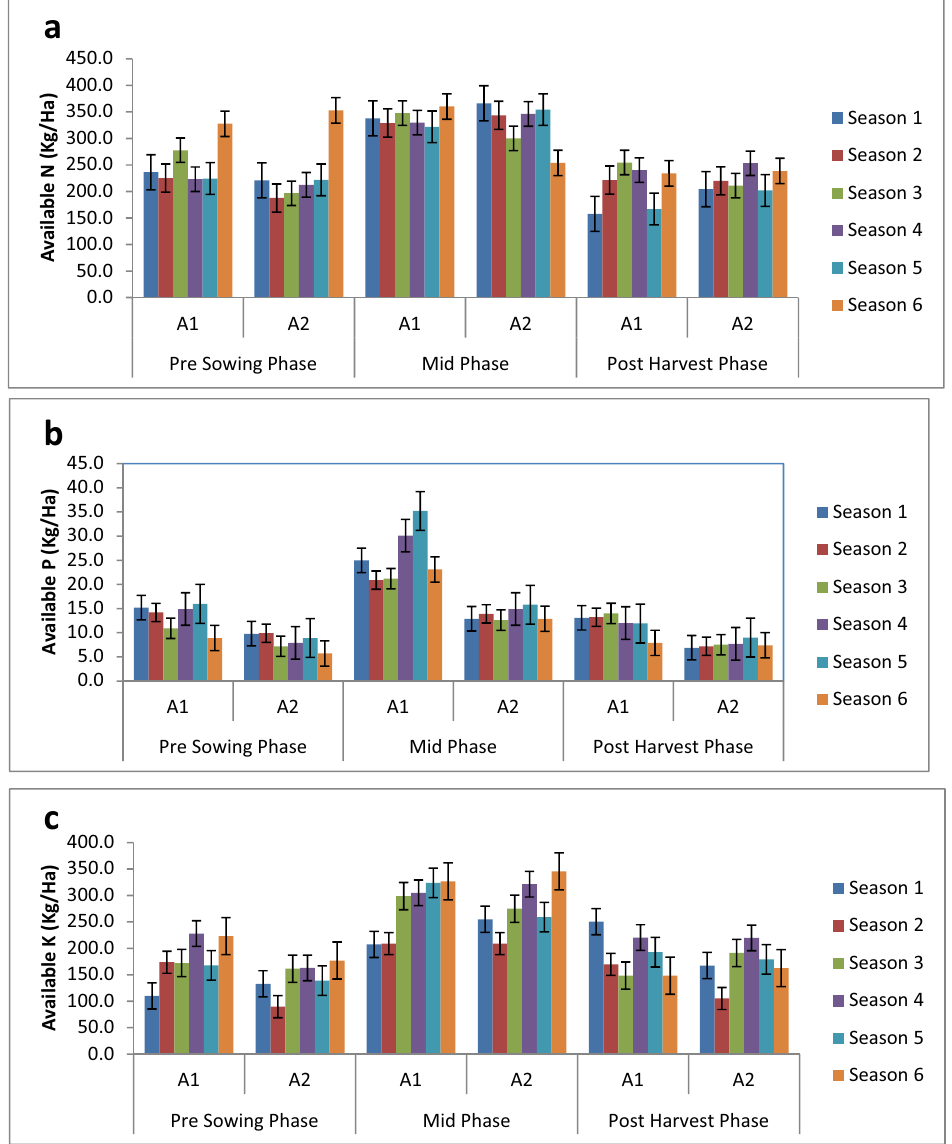
Figure 2. ( a ) Seasonal Variation in Available Nitrogen in A1 and A2 under different phases of crop growth. ( b ) Seasonal Variation in Available P in A1 and A2 under different phases of crop growth. ( c ) Seasonal Variation in Available Potassium in A1 and A2 under different phases of crop growth. ( d ) Seasonal Variation in Sulphur in A1 and A2 under different phases of crop growth. ( e ) Seasonal Variation in Calcium in A1 and A2 under different phases of crop growth. ( f ) Seasonal Variation in Magnesium in A1 and A2 under different phases of crop growth. ( g ) Seasonal Variation in SOC in A1 and A2 under different phases of crop